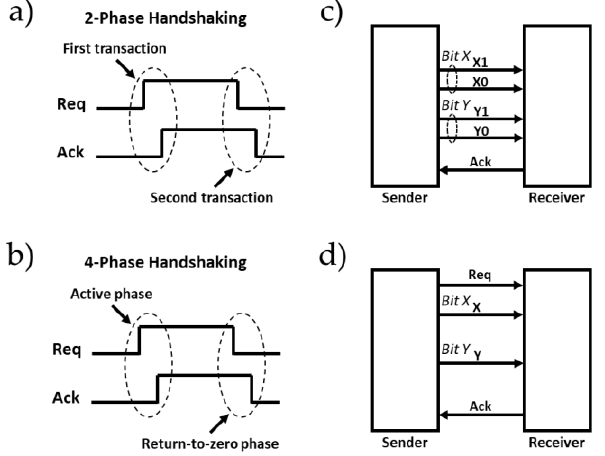
Figure 4. ( a ) Non-return-to-zero handshake protocol. ( b ) Return-to-zero handshake protocol. ( c ) Dual-rail data encoding. ( d ) Single-rail data encoding [26].